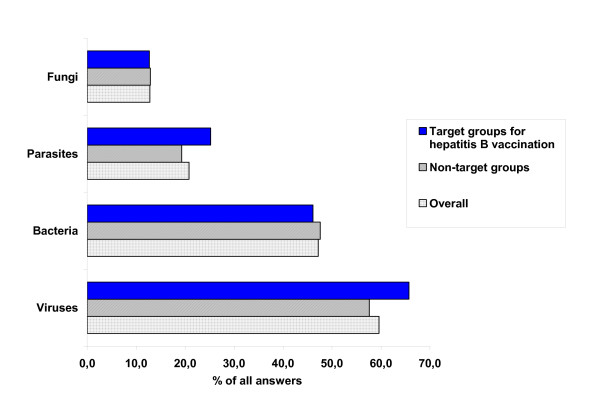
Identification of etiologic agents for HB in sample population. Standardised results (sex, age group and regional distribution), Germany, November 2004 (n = 412)